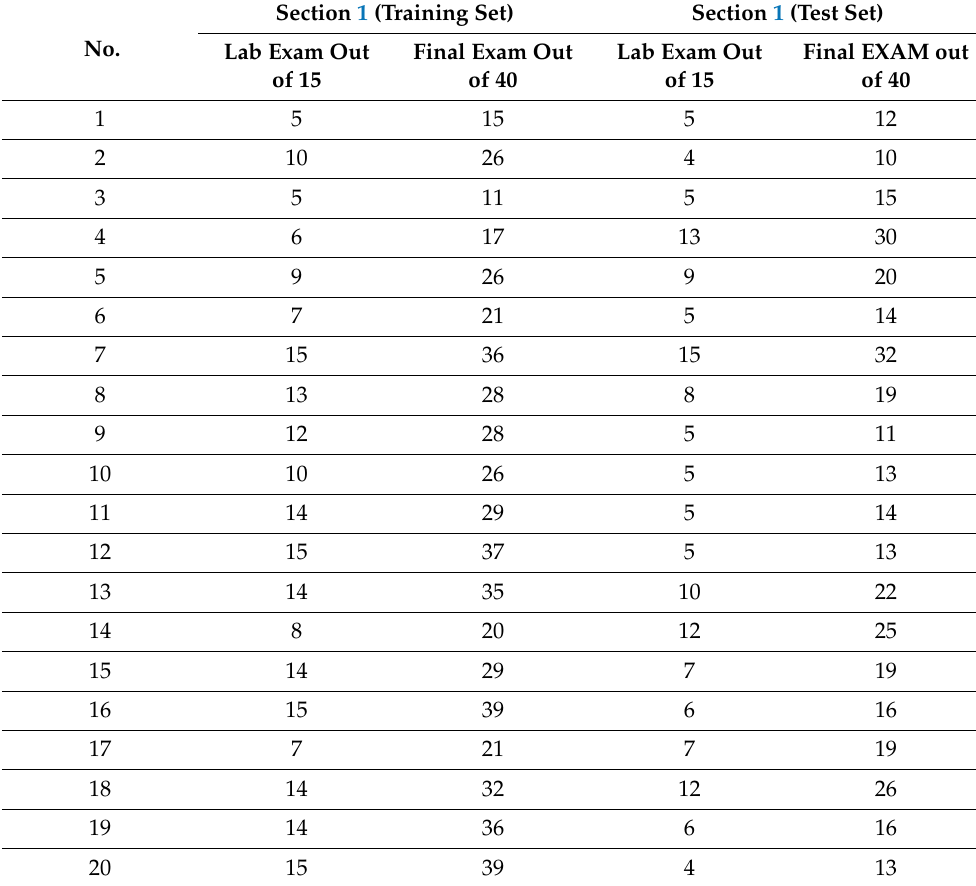
Table 6. The data set of the second experiment (related data sets—Section 4.2).